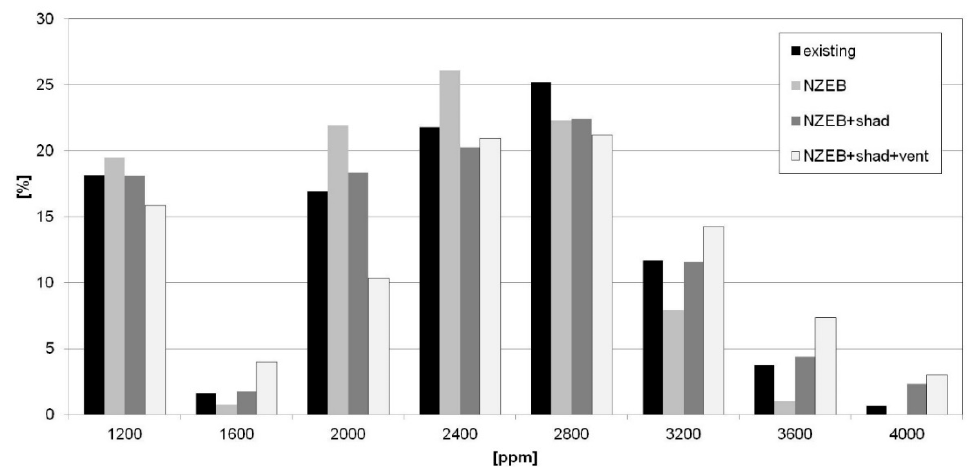
Figure 8. Frequency distribution of CO 2 concentration in the south-oriented classroom in Rome.